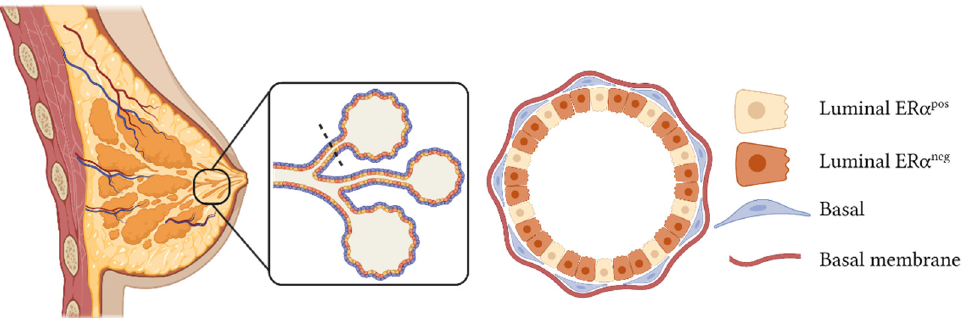
Figure 1. Model of normal mammary gland structure. This tissue is composed of ducts, which are formed by three epithelial populations: basal cells, in contact with the basal membrane; estrogen receptor-positive (ER α pos ) luminal cells; and estrogen receptor-negative (ER α neg ) luminal cells. The dotted black line indicates the cross-section of the mammary duct represented in the magnified scheme on the right. This figure was created with Biorender.com (accessed on 12 December